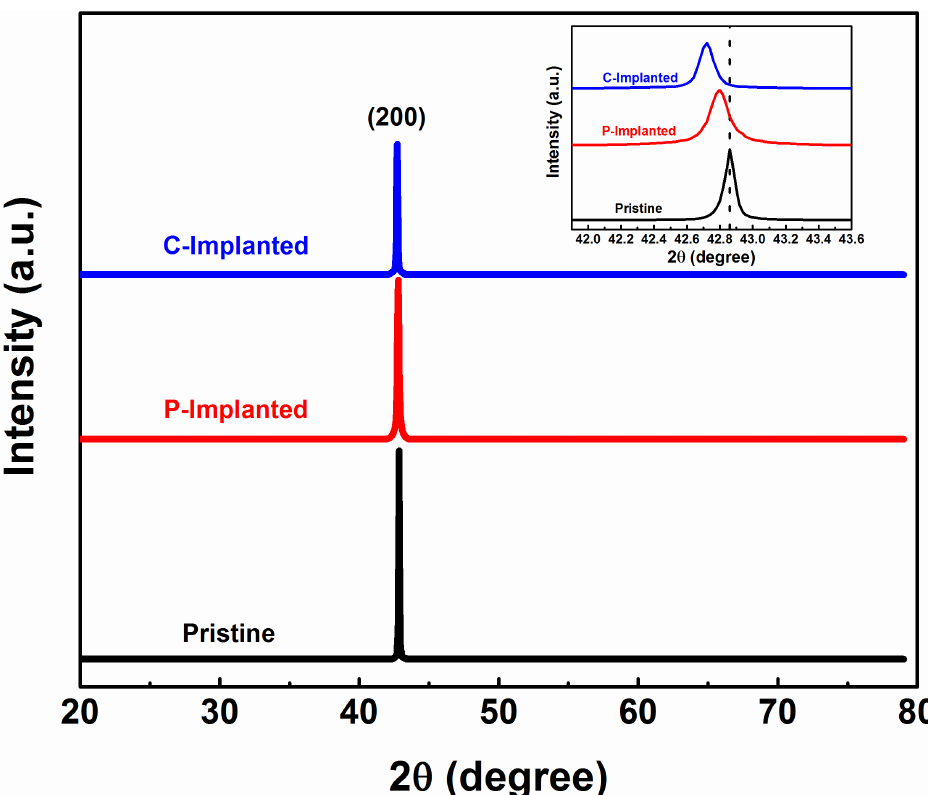
Figure 2. HRXRD patterns of pristine, C-implanted and P-implanted MgO samples, obtained using ω-2θ mode. The inset shows the magnification of MgO (200) peaks.